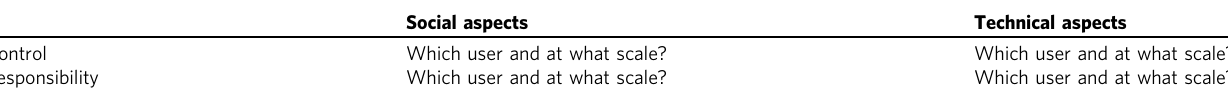
Table 1 Control and responsibility in a multi-scalar socio-technical